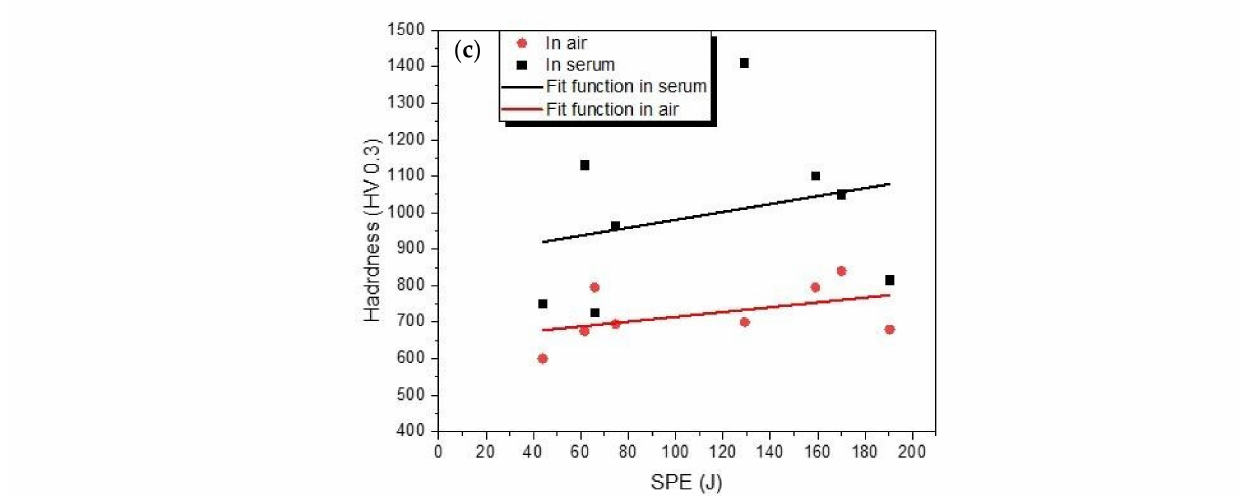
Figure 13. The variations of the hardness HV (0.3) with focal position ( a ), energy ( b ), and ( c )